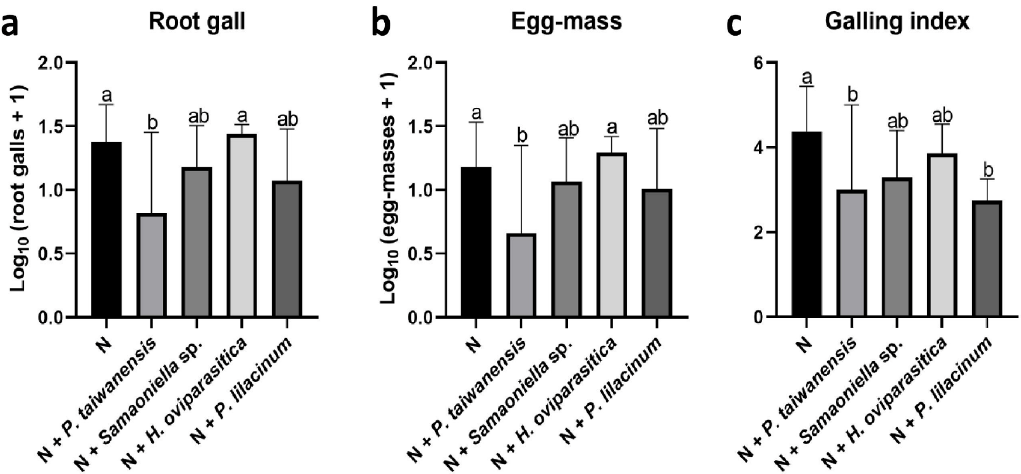
Figure 6. Effects of P. taiwanensis , Samsoniella sp. strain NTUCC 18–159, H. oviparasitica DoUCR50 , and P. lilacinum strain 251 (PL251) on M. enterolobii in the second greenhouse trial. ( a ) root gall, ( b ) egg mass, ( c ) galling index. N is the nematode-only treatment. Different letters indicate significant differences among treatments by Fisher’s LSD test ( P < 0.05), respectively.